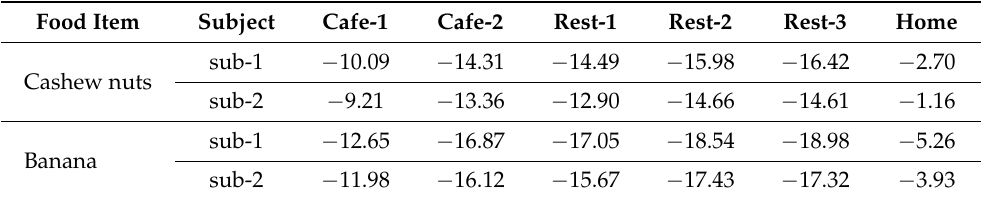
Table 5. An example of the measured SNR (in dB) for the various eating environments, for the two subjects (sub-1 and sub-2) and for the two food items (cashew nuts and banana). Food Item Subject Cafe-1 Cafe-2 Rest-3 Home sub-1 Cashew nuts